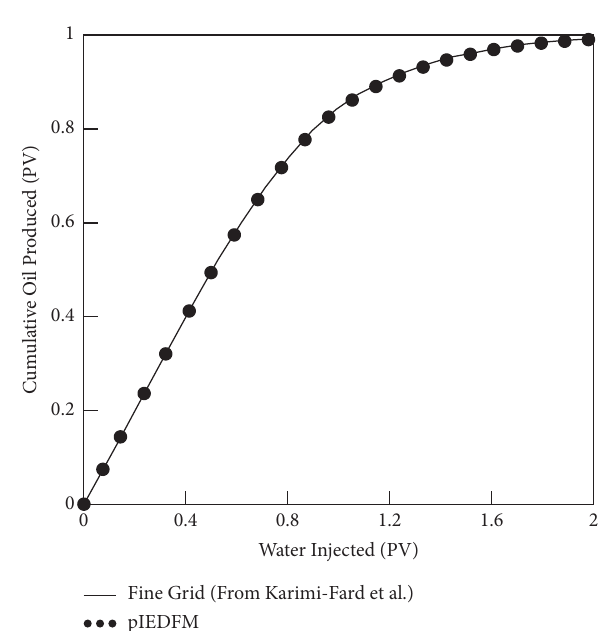
Figure 7: Comparison of cumulative oil